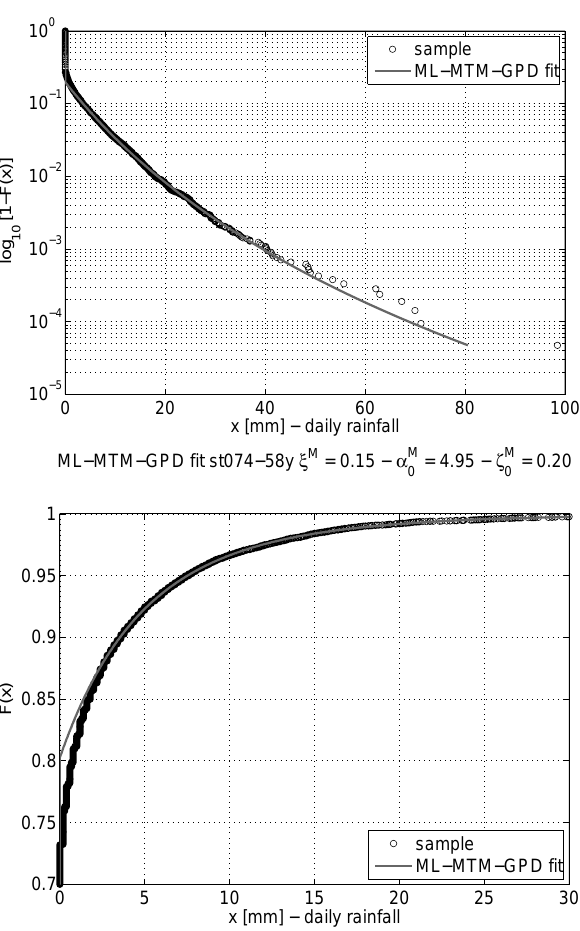
Fig. 2. Example of MTM application on a daily rainfall time series Fig. 3. These figures display the good GPD fitting obtained by collected by a tipping-bucket rain gauge with a 0.2mm resolution. MTM application showed in Fig. 2. The top plot shows the em- The first plot from the top displays the ξ estimates as the threshold u pirical survival function (circles) and Eq. (10) parameterized with ranges from 0 to 20mm: the ξ M MTM estimate is the median value MTM estimates (line): we can observe how the fitting can reliably (horizontal line) within the range of thresholds between 2.5 and capture the highest records, despite the fact that the MTM was ap- 12.5mm suggested for practical applications. Similarly, the sec- plied with a moderate range of thresholds up to 12.5mm. The bot- ond and third plots display the unconditioned α 0 and ζ 0 estimates tom plot shows a zoom of the empirical CDF and the MTM-GPD provided by Eqs. (8) and (9) as a function of u . In the fourth plot the fit with the same symbols: we can observe again a good fitting, ex- α M MTM estimate is obtained as the median value of the reparam- 0 cept for very small records below the optimum threshold u ∗ ≈ 3mm estimates conditioned to the ξ M MTM estimate, while eterized α C 0 detected in previous Fig. esti- in the fifth plot the ζ M MTM estimate is obtained by the ζ C 0 0 mates conditioned to both ξ M and α M MTM estimates. The sixth 0 plot shows the sizes of the records exceeding the thresholds u . The starting point of stabilization of all estimates suggests u ∗ ≈ 3mm as an optimum threshold.